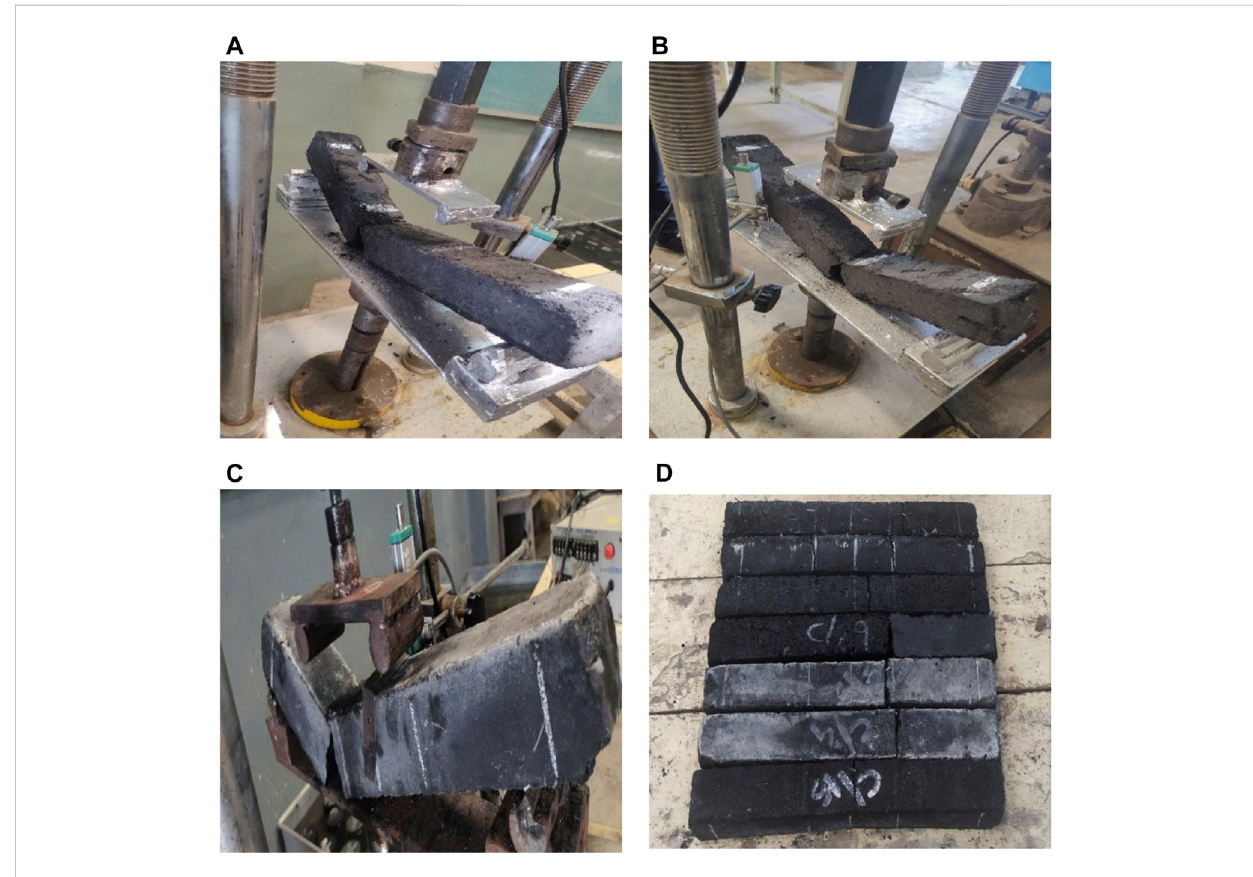
FIGURE 15 Development of cracks in beam specimens (A – D)